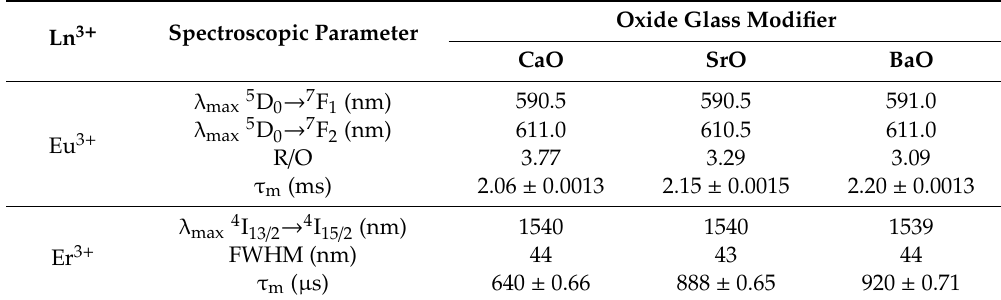
Figure 11. Luminescence spectra for Er 3+ -doped phosphate glasses with oxide glass modifiers MO. Table 3. Spectroscopic parameters for Ln + -doped phosphate glasses.